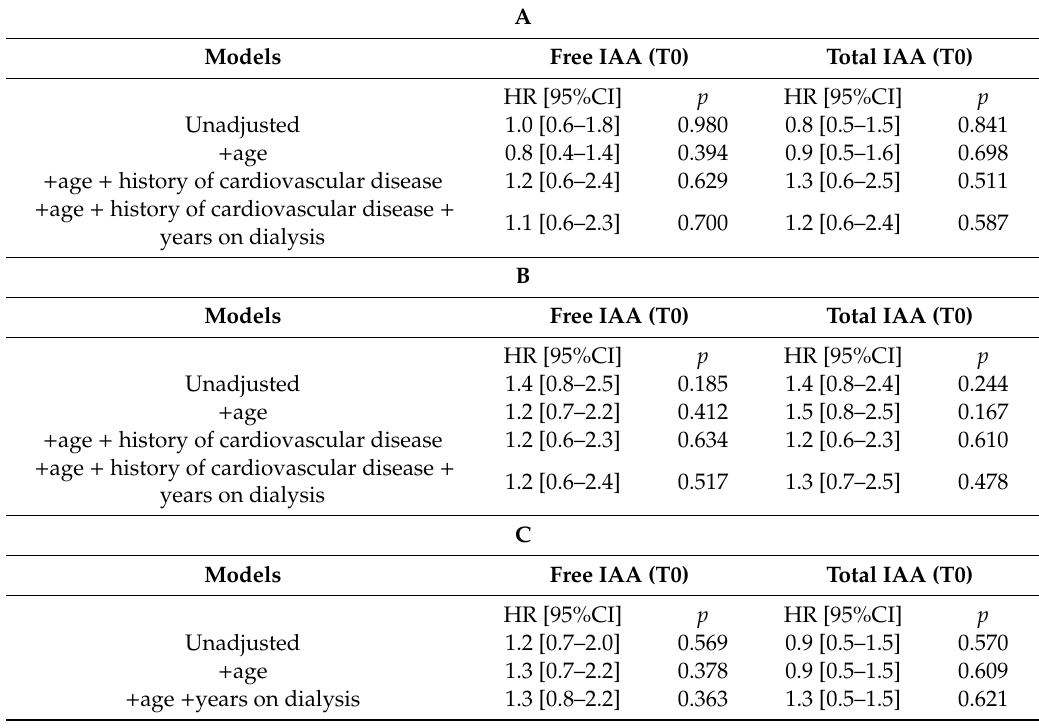
Table 3. A Cox proportional hazards analysis of plasma free and total IAA levels at the time of transplantation time (stratified by the median) in predicting (A) all-cause mortality, (B) cardiovascular events and (C) graft loss in the transplanted cohort (n =